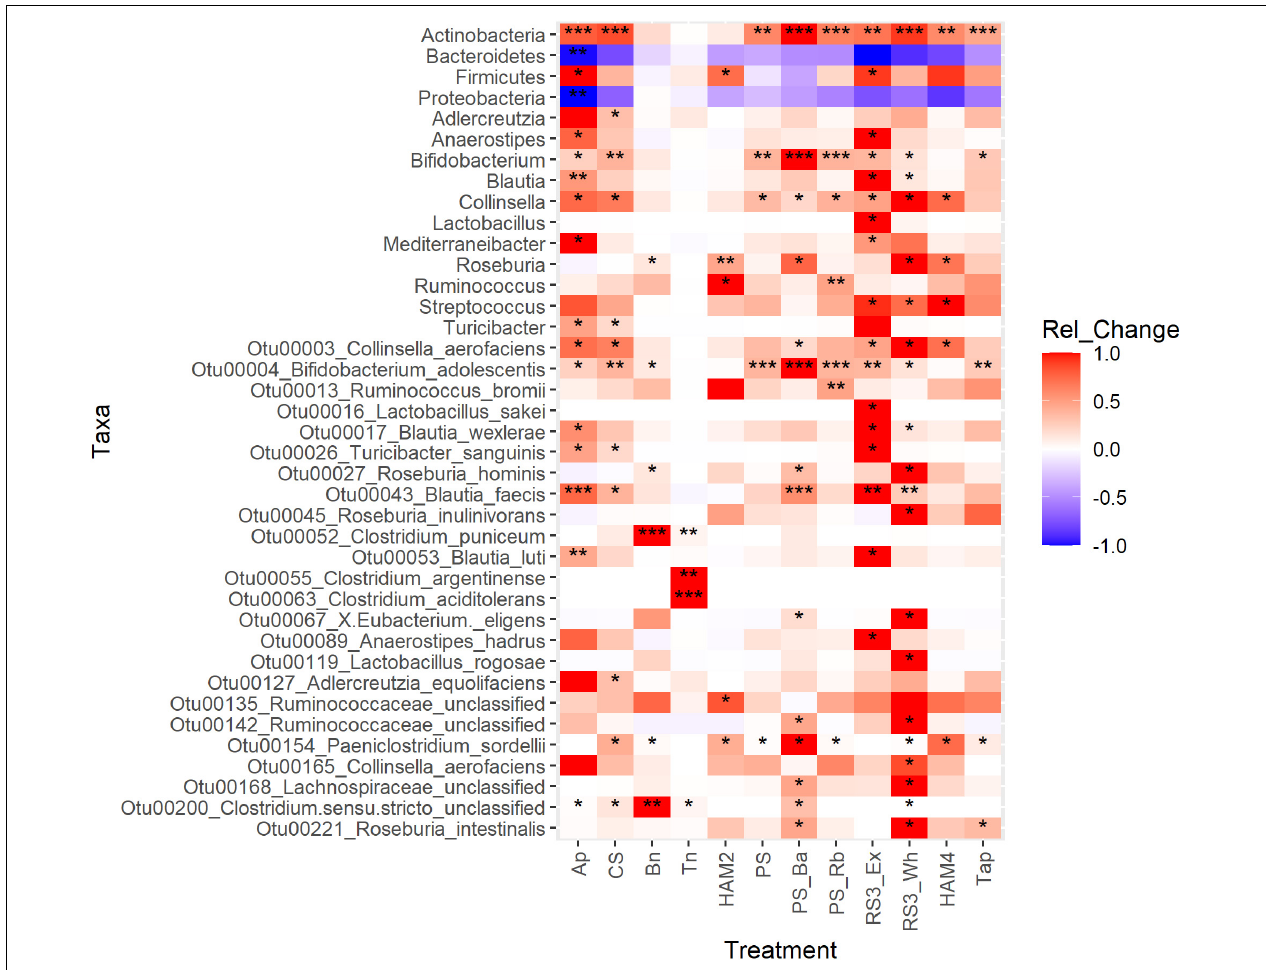
FIGURE 5 | Differential abundance analysis heatmap of taxonomic features between treatments. The heatmap is colored by the standardized change in the relative abundance of the taxon between the treatment and the control. Red indicates a positive change; blue indicates a negative change. Significant differences were calculated by three methods: LEfSe, DESeq2 and ANCOM-II. Significance is indicated by * for one method finding the taxon significantly different between that treatment and the control, ** for two methods detecting significant difference and *** for all three methods detecting a significant change. For LEfSe and DESeq2, adjusted P -values of 0.05 were used as the cutoff for significance, while for ANCOM-II which does not generate P -values, the default cutoff threshold of 0.7 was used. Ap, amylopectin; CS, corn starch; Bn, green banana flour; Tn, tiger nut flour; HAM2, high amylose maize starch; PS, potato starch; PS_Ba, potato starch with fecal samples supplemented with Bifidobacterium adolescentis ; PS_Rb, potato starch with fecal samples supplemented with Ruminococcus bromii ; RS3_Ex, retrograded extracted potato starch; RS3_Wh, retrograded whole potatoes; HAM4, chemically cross-linked high amylose maize starch; Tap, chemically cross-linked tapioca